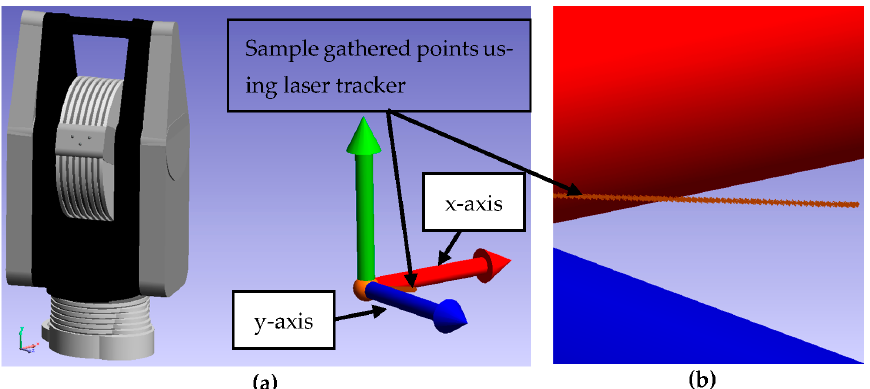
Figure 6. Spatial analyzer software environment ( a ) whole software screenshot; ( b ) zoomed in position data.